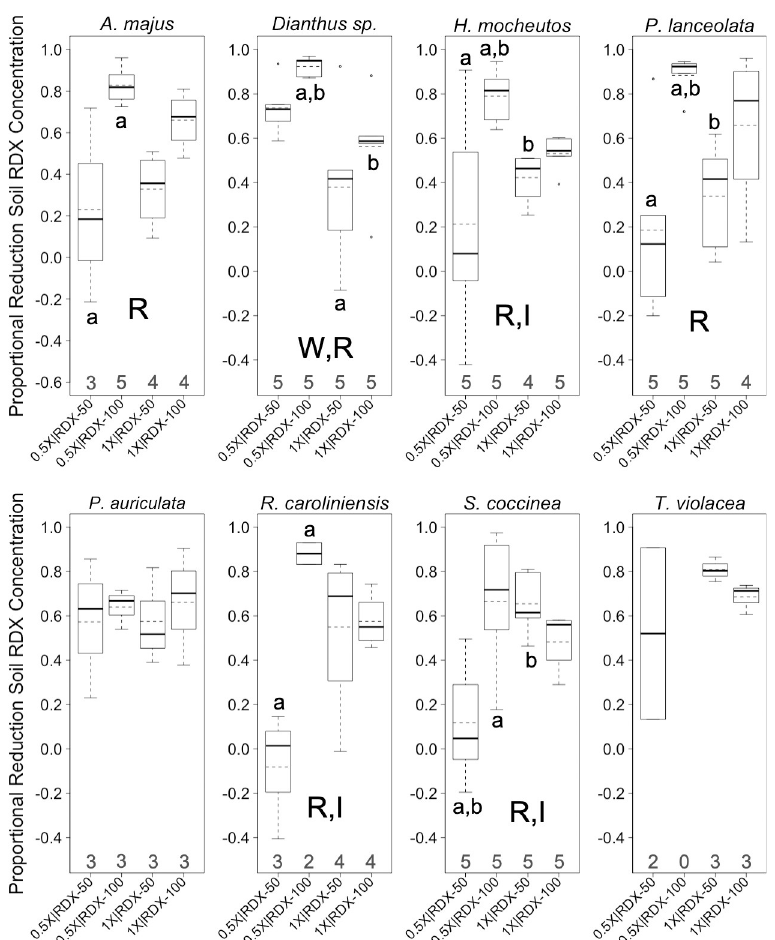
Fig 2. Proportional reductions in soil RDX in greenhouse trials. Boxplots of proportional reductions in soil RDX concentrations ( PRC s) for eight plant species reared for 133 days in a greenhouse under different combinations of two factors, water-resourcing level (1X and 0.5X) and soil RDX concentration (50 and 100 ppm). Boxplots include median (bold horizontal line) and mean (dotted horizontal line) values. Sample sizes within each group are found on the x- axis. R = significant effect of soil RDX concentration; W = significant effect of water-resourcing level; I = significant interaction effect; a, b = significant pairwise difference between treatment groups. α � 0.10.